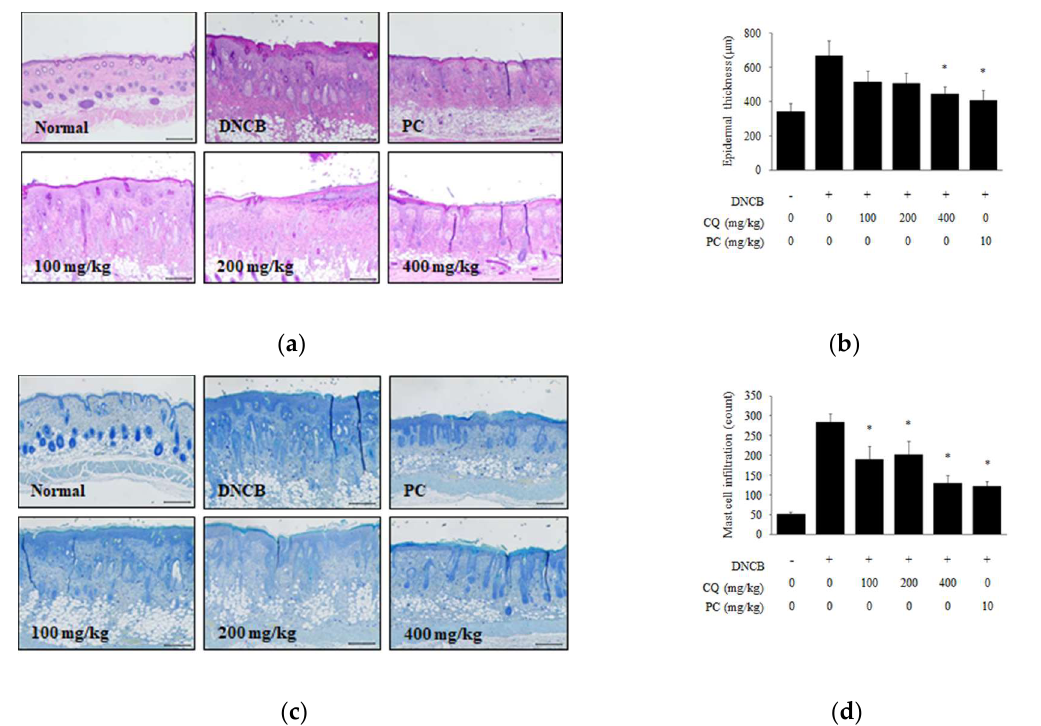
Figure 5. Histological analysis of epidermal thickness and mast cell infiltration on DNCB-induced skin lesions. ( a , b ) To observe epidermal thickness, dorsal skin section was stained with H&E and taken using a light microscope at × 100 magnification (scale bar = 100 µ m); ( c , d ) To observe mast cell infiltration, dorsal skin section was stained with TB and taken using a light microscope at × 100 magnification (scale bar = 100 µ m). All data are presented as mean ± SD; * p < 0.05 vs. DNCB-induced group.